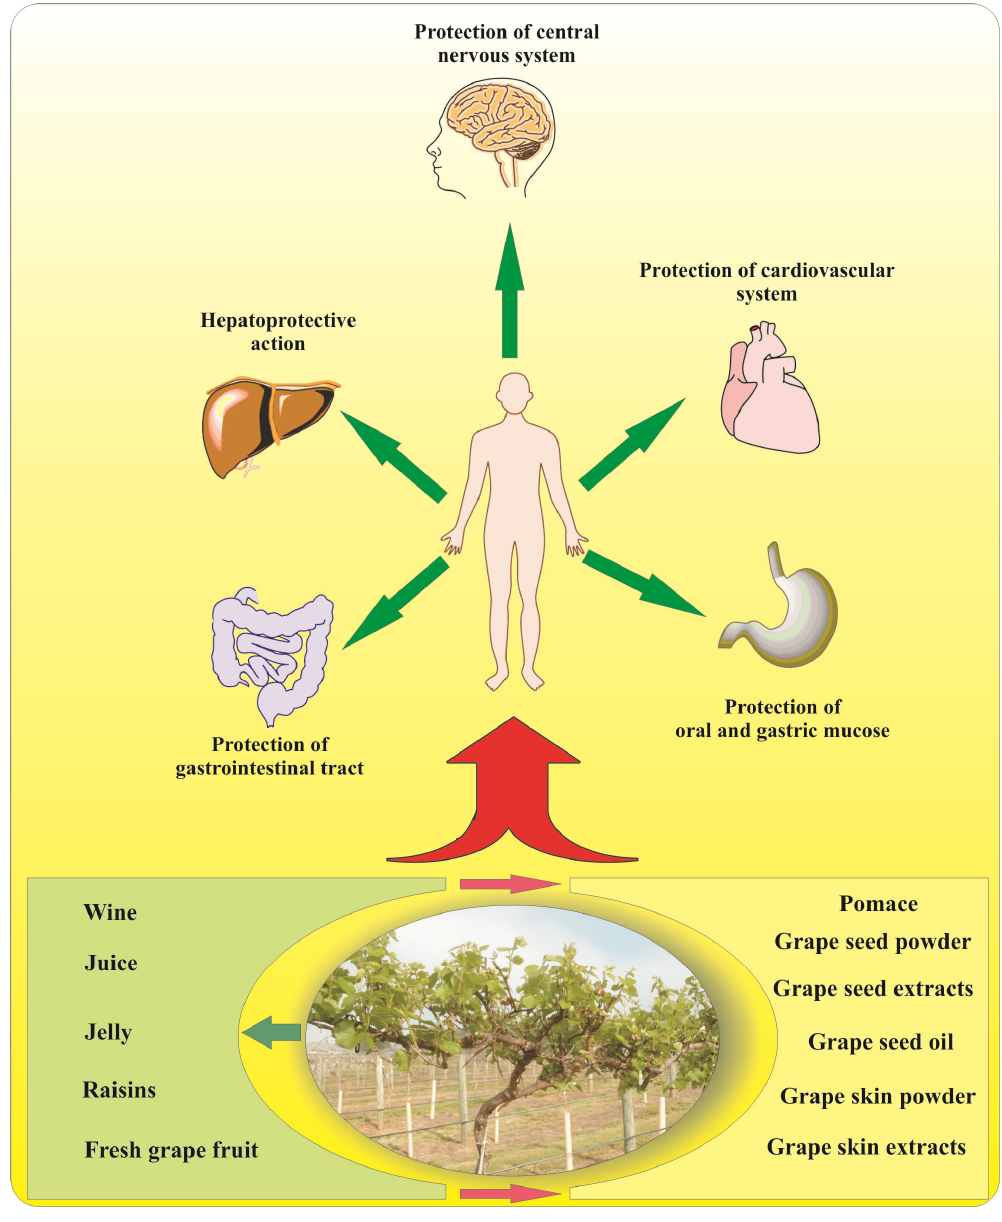
Figure 1. Primary grape products and byproducts and their beneficial effects on human